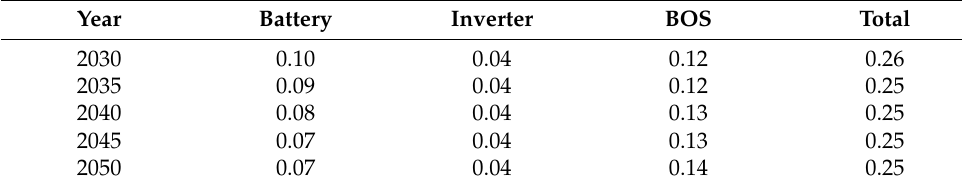
Table A11. Projection cost of 1 MWh BESS unit (optimistic case)